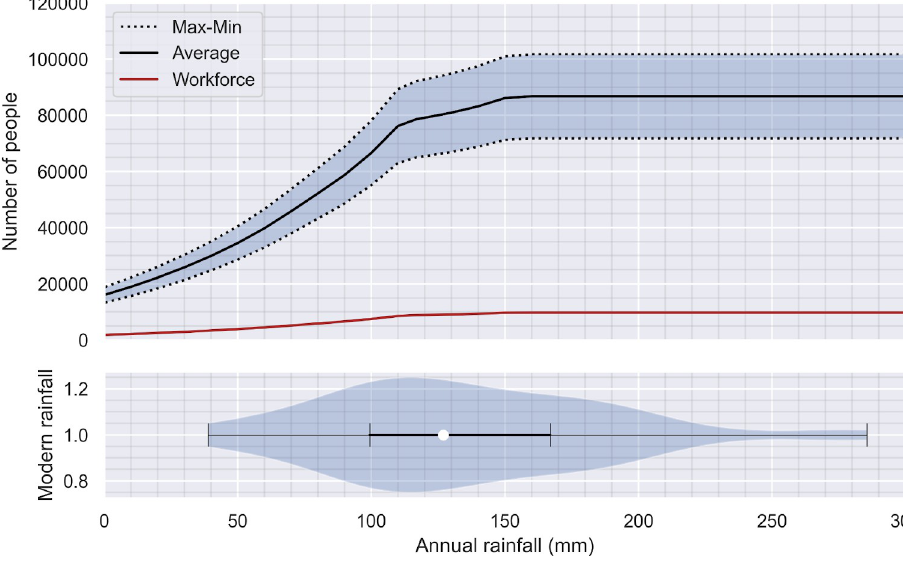
Fig 4. Carrying capacity in relation to rainfall. Top: the relationship between population numbers and yearly rainfall levels. Bottom: a violin plot showing the distribution of yearly rainfall between 1934 and 1999 shows the range of feasible population sizes give twentieth century levels of rainfall